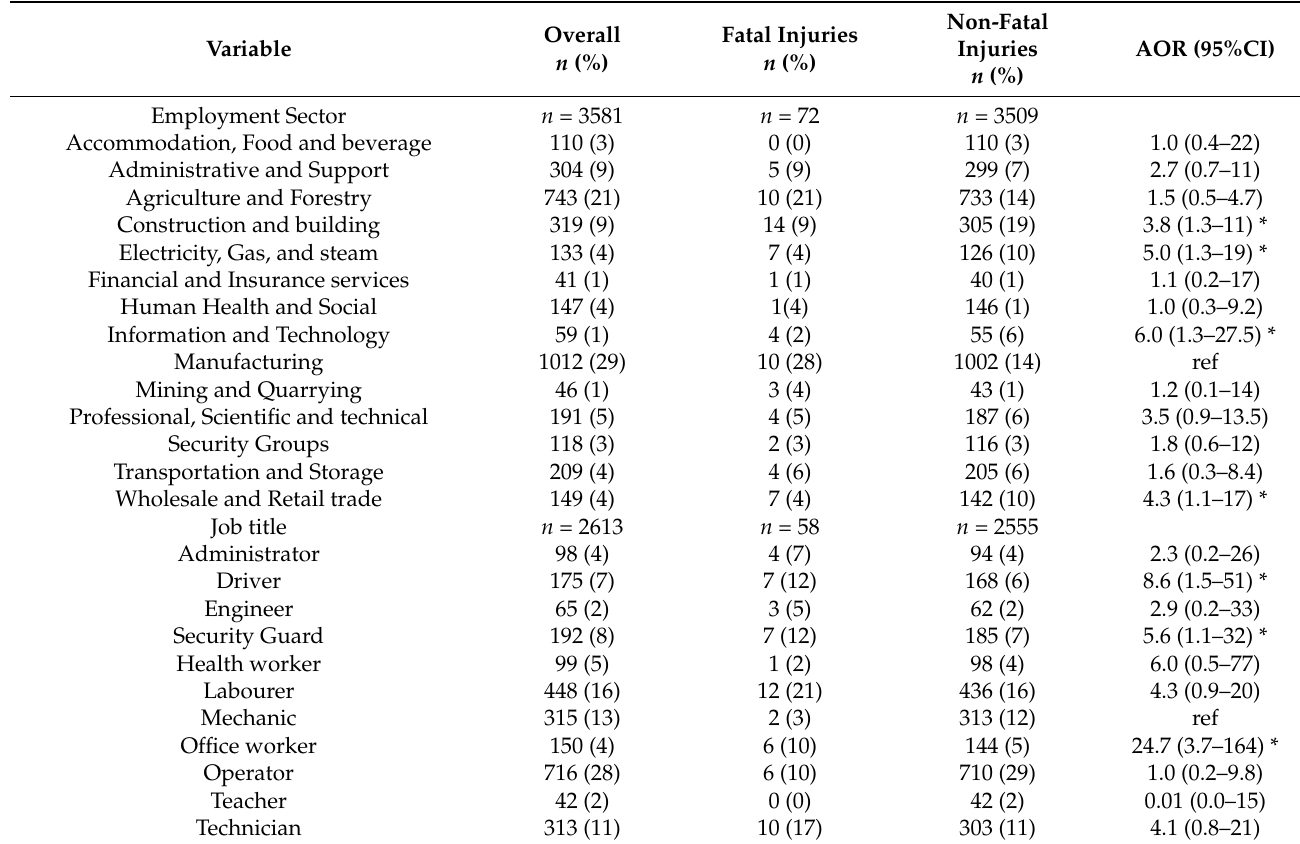
Table 5. Work-related injuries (excluding motor traffic accidents) reported to WCF classified by employment sector and job